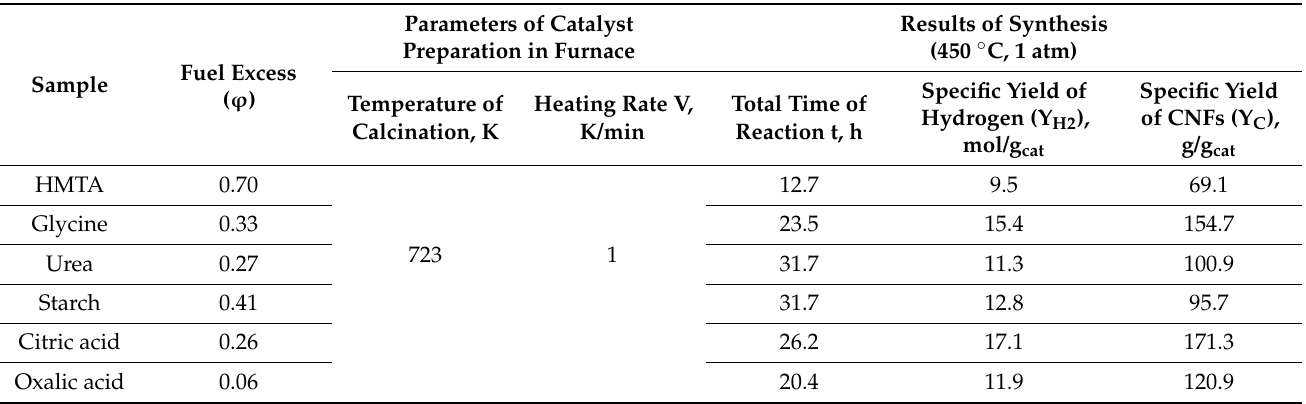
Table 1. Summary data on the synthesized catalyst samples.